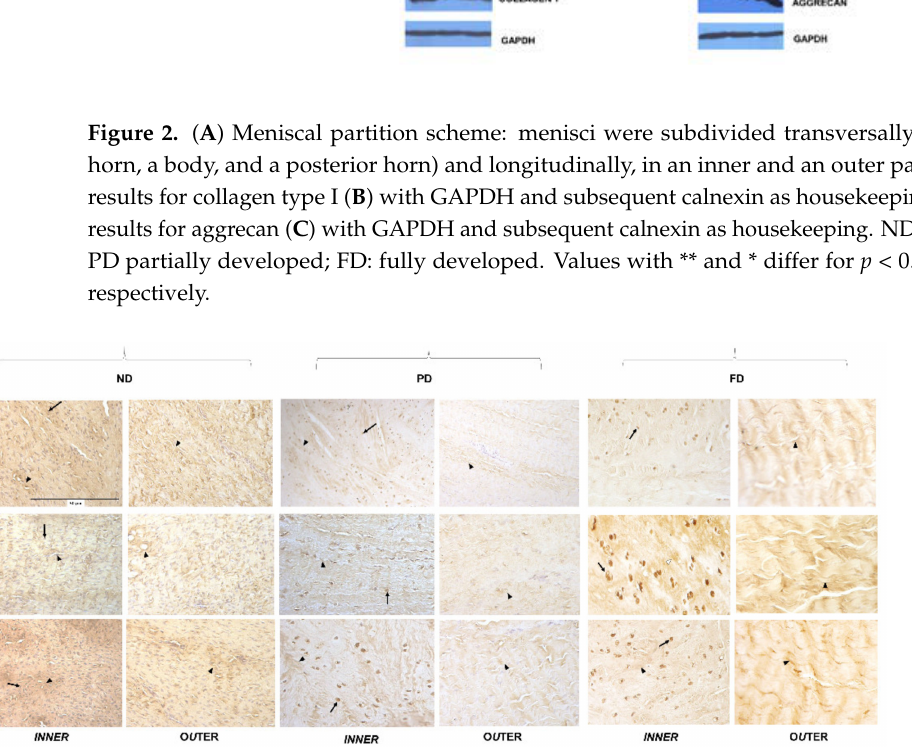
Figure 3. Collagen I immunostaining in the inner and outer regions of the anterior horn, body, and posterior horn of ND, PD, and FD. Arrows: nuclei, arrowheads: fibers. All the images have the same scale bar (located in the first image: 50 µ